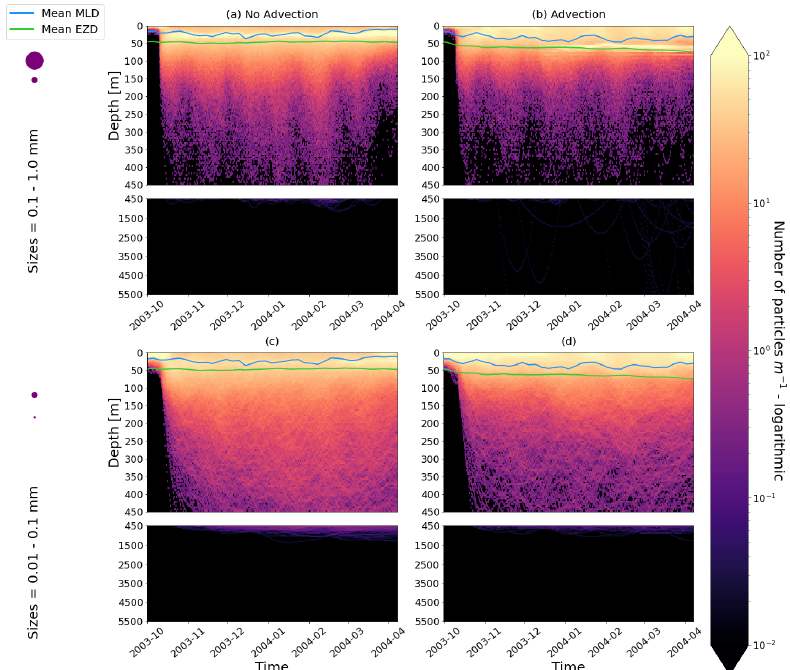
Figure E2. As in Fig. 2 but for particles only in the EqPac and running for 180d. The left two figures are without advection, and the right two figures are with advection. This means that (a) and (c) are identical to Fig. 2a and d, however, including the 3-month spin-up time and running for fewer days (not a full year).